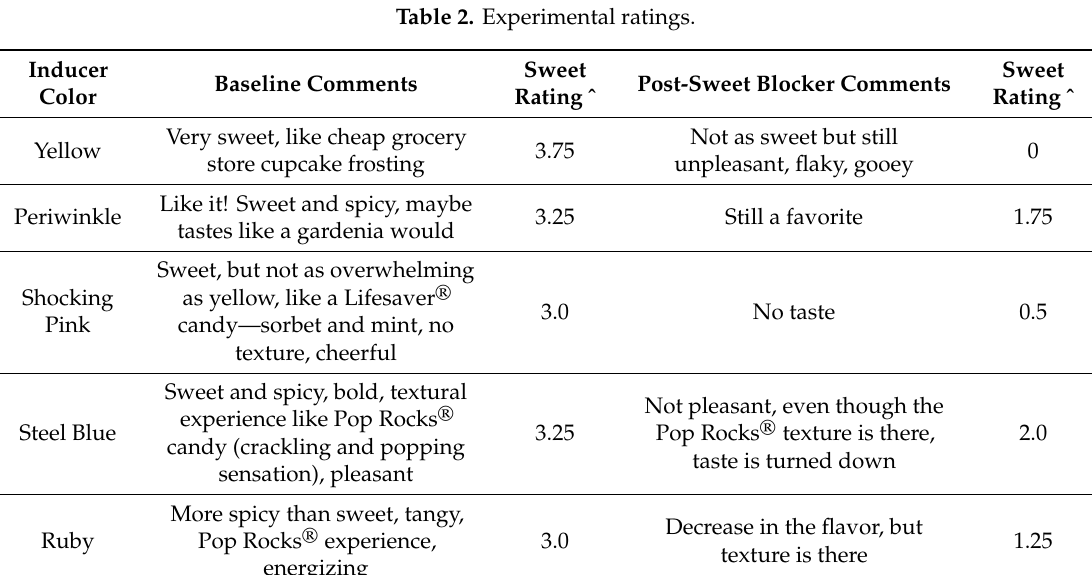
Table 2. Experimental